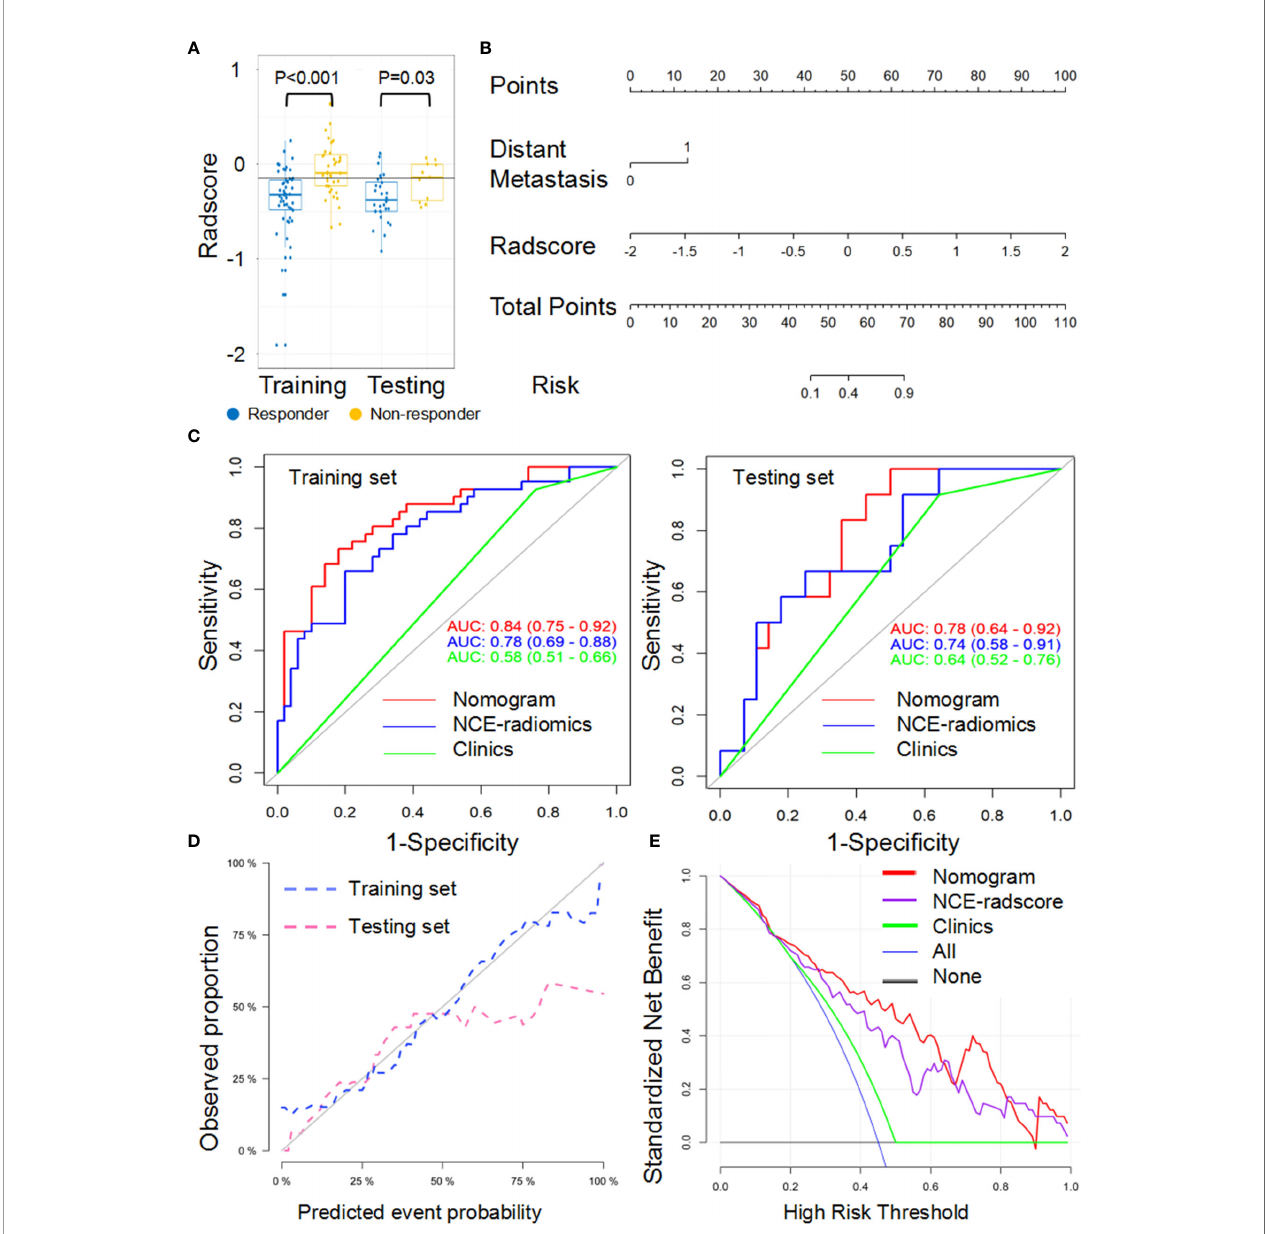
FIGURE 3 | Performance of the NCE-radiomic models from largest lesion approach in training and testing sets. (A) Box and whisker plots depict radscore comparison between responders and non-responders. (B) NCE-radiomic nomogram developed in training set. (C) ROC curves of radiomics signatures in training and testing sets. (D) Calibration curve analysis for the nomogram in training set and testing set. (E) Decision curve analysis for the nomogram (red), radscore (purple), and clinical model (green). The y-axis indicates the net bene fi t; x-axis indicates threshold probability. The blue line represents the assumption that all patients were responders. The black line represents the hypothesis that no patients were